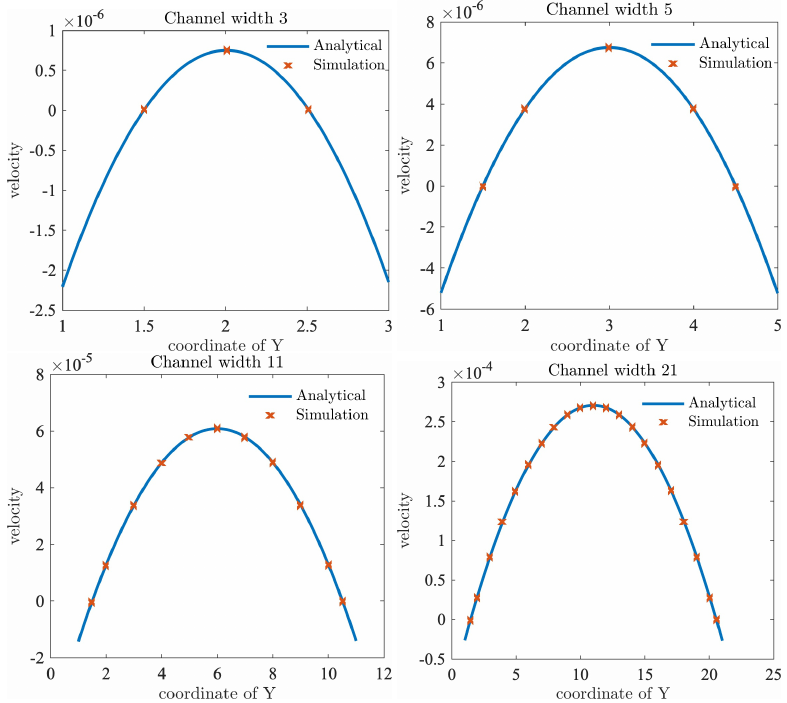
Figure 1. The velocity field compared with the analytical solution under different channel widths of 3, 5, 11, and 21 lattice size.